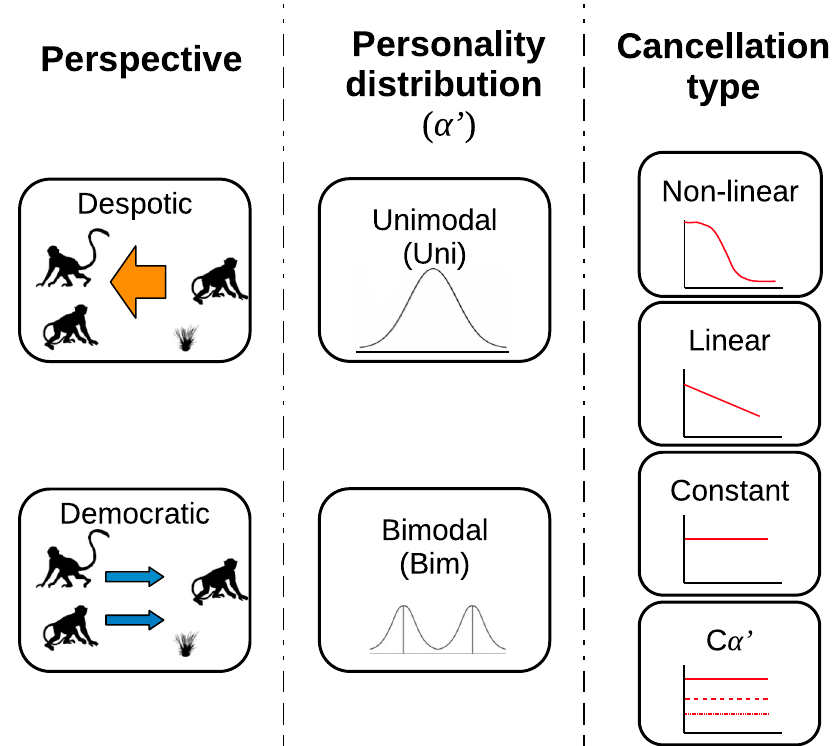
Fig. 2 Summary of the components of our full-factorial simulation analysis. Perspective determines whether the propensity for potential followers to join a movement depends on the personality of the initiator (despotic) or their own personality (democratic). Personality distribution de fi nes the distribution of personality types in the group. Cancellation type models how an initiator ’ s propensity to give up depends on the number of